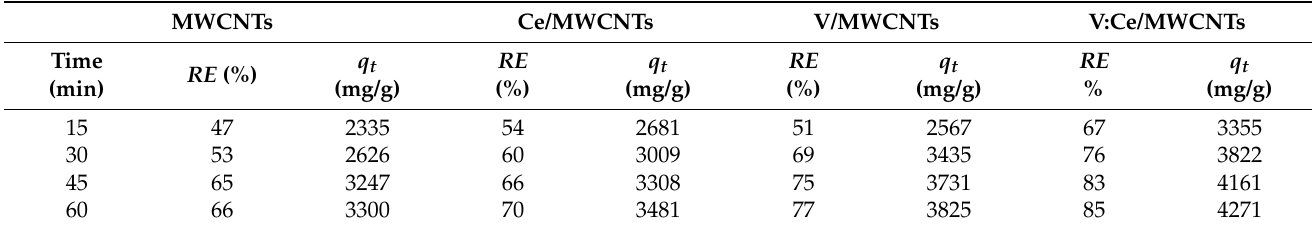
Table 3. GC results of the adsorption capacity and removal efficiency of kerosene from water, using